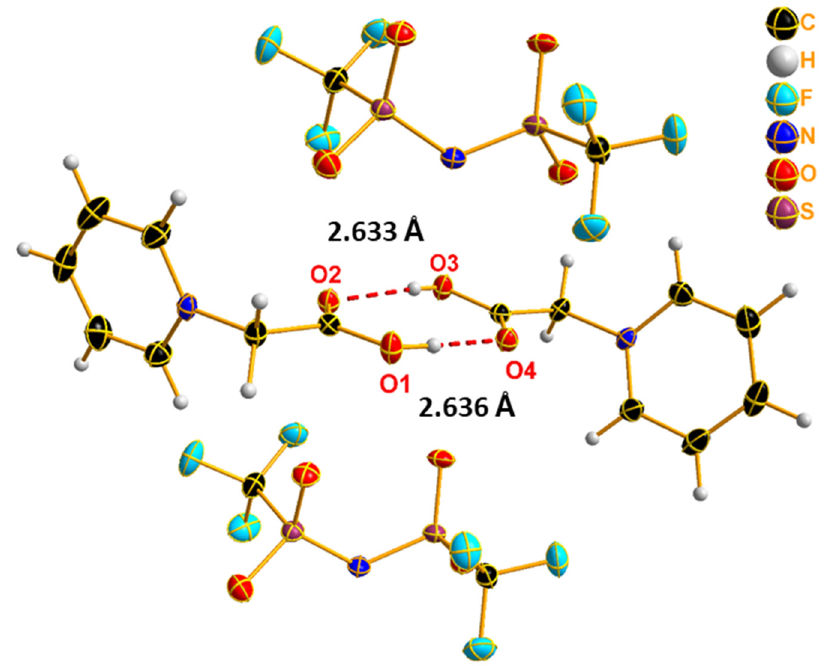
Figure 1. Solid-state structure of the ionic liquid 1–(carboxymethyl)pyridinium bis(trifluoromethylsulfonyl)imide [HOOC–CH 2 –py][NTf 2 ]. The X–ray structure shows the favorable double H-bond motif formed between the carboxyl-functionalized cations, whereas the weakly interacting anions are not involved in hydrogen bonding. In the ORTEP representation, the atoms are represented by ellipsoids at 50% probability levels. The hydrogen bonds are denoted by a dashed line.